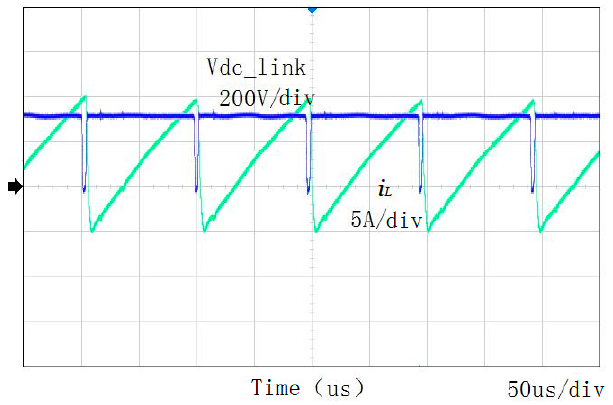
Figure 13. Experimental platform.